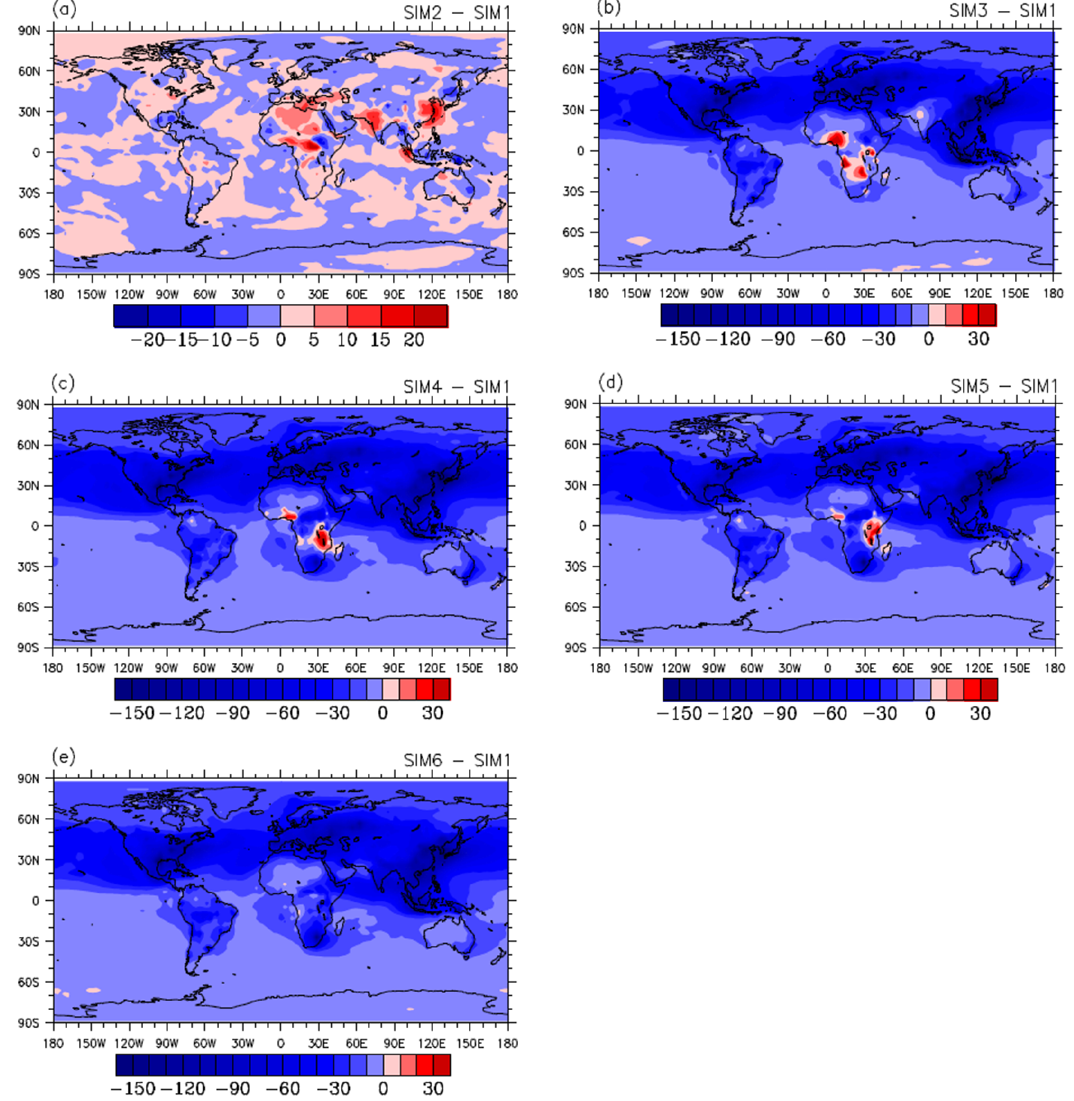
Figure 4. Global distributions of difference in simulated annual mean CCN concentration at surface (units: cm − 3 ). (a) SIM2–SIM1, (b) SIM3–SIM1, (c) SIM4–SIM1, (d) SIM5–SIM1, and (e)